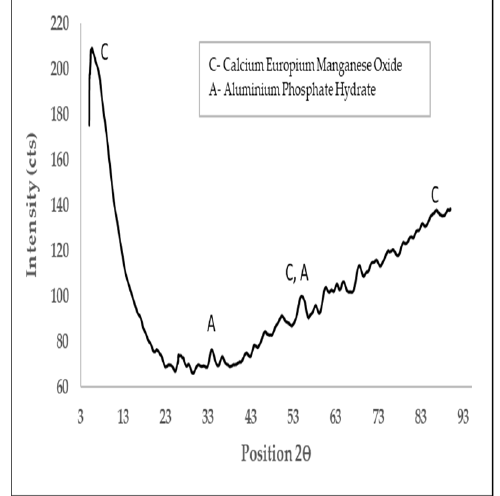
Figure 24. XRD pattern of SRMB.